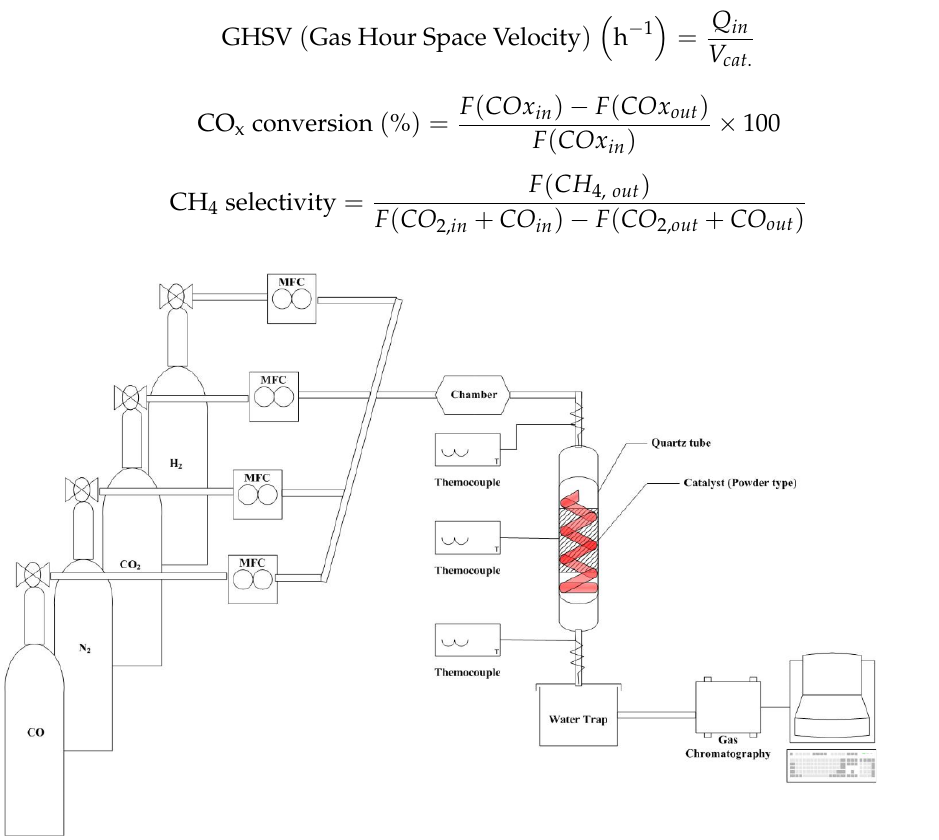
Figure 3. Schematic diagram of CO 2 methanation reactor.